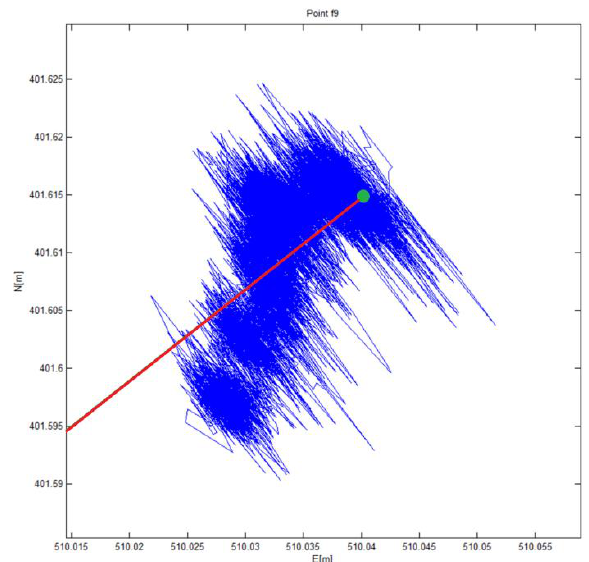
Figure 19.Envelope of the planimetric position obtained by corrected observations for point